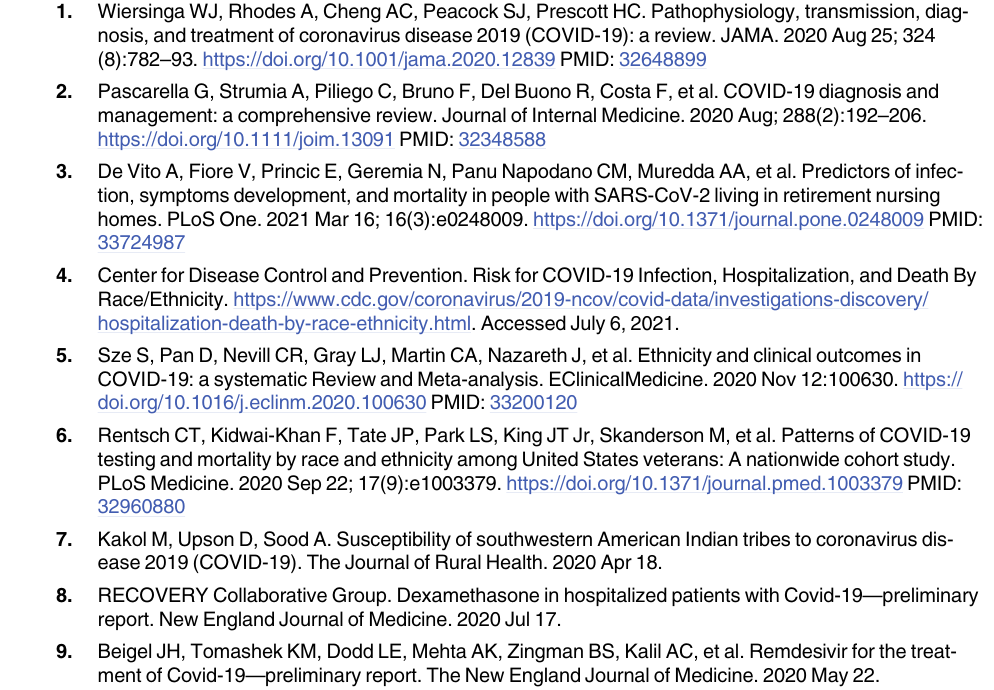
S9 Fig. Cumulative incidence for discharge by admitting hospital and race. N = 6255. Site 1 (n = 1762), Site 2 (n = 1048), Site 3 (n = 1030), Site 4 (n = 1163), Site 5 (n = 1252) are